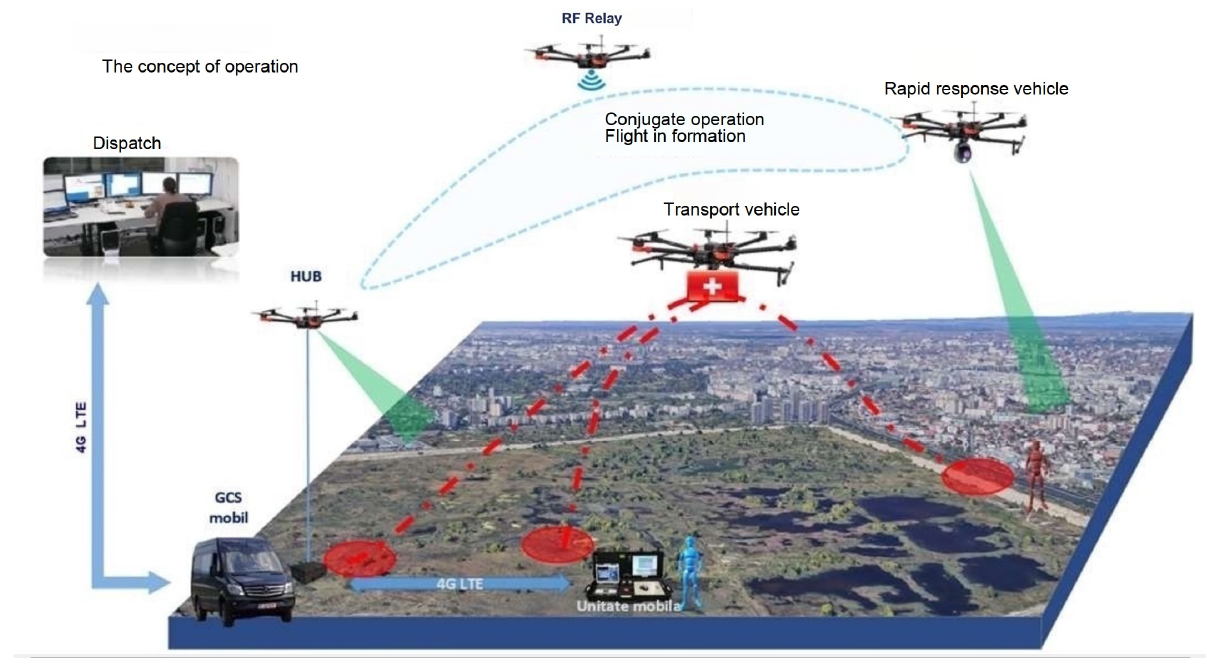
Figure 6. System components and concept of operation.